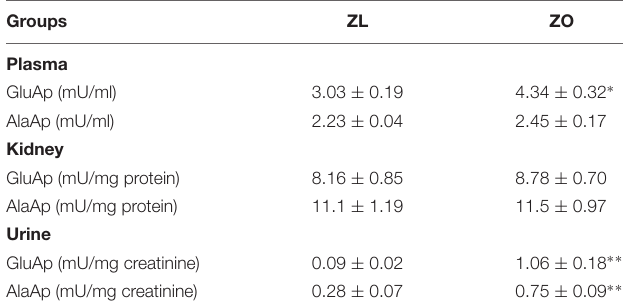
TABLE 4 | Plasmatic, renal and urinary enzymatic activities of GluAp and AlaAp at 8 months old in male Zucker lean (ZL) and Zucker obese (ZO) rats. Groups